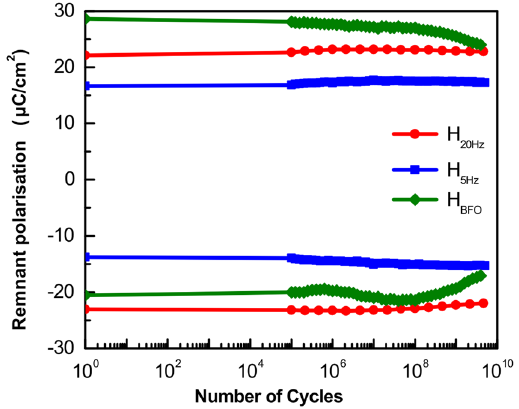
Figure 6. Plot of remanent polarization versus number of switching